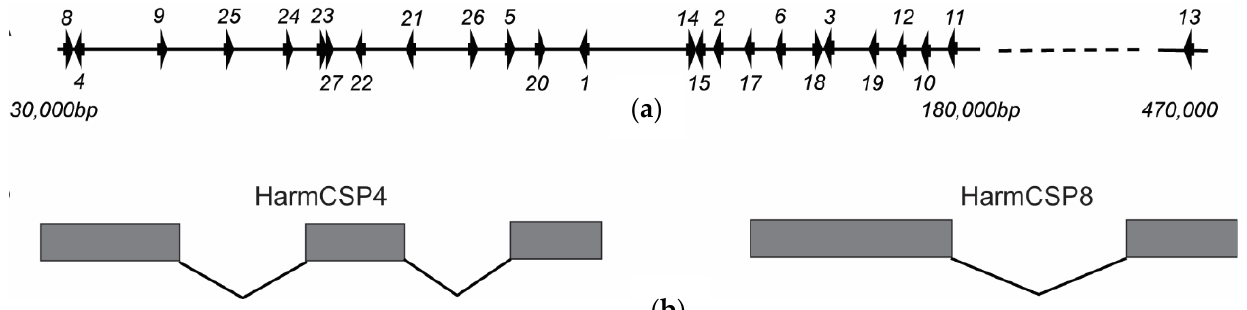
Figure 2. The schematic representation and structural analysis of H. armigera CSPs. ( a ) The location on scaffold 119 and ( b ) exon/intron structures of 25 H. armigera CSP genes. Introns are labeled using full lines while exons are representted using solid blocks. HarmCSP8 and 4 are used as examples for two groups of CSPs in exon/intron structures.